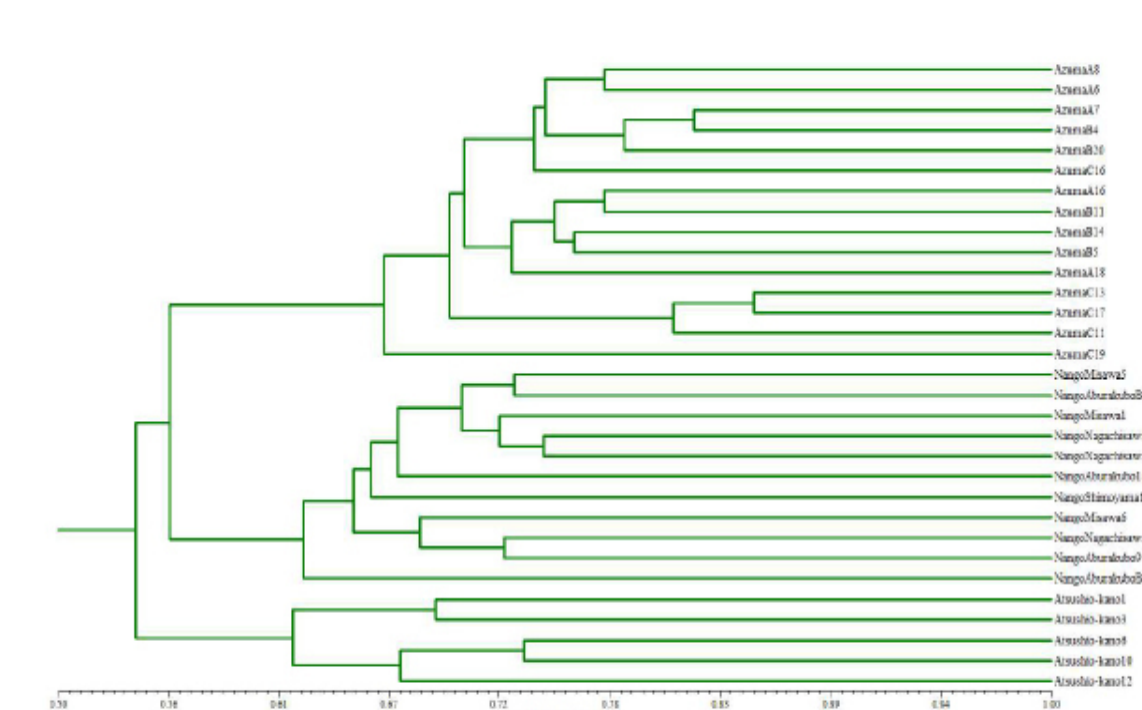
Figure 5. UPGMA dendrogram based on JaccardÆs similarity coefficients